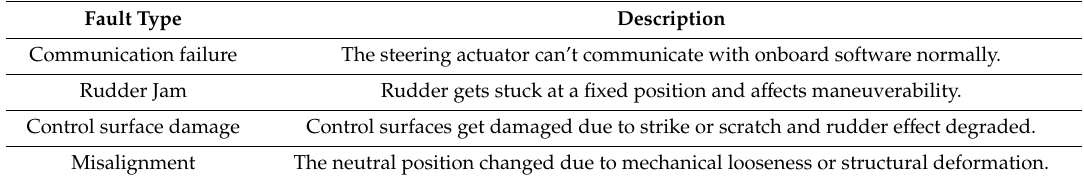
Table 1. Rudder faults